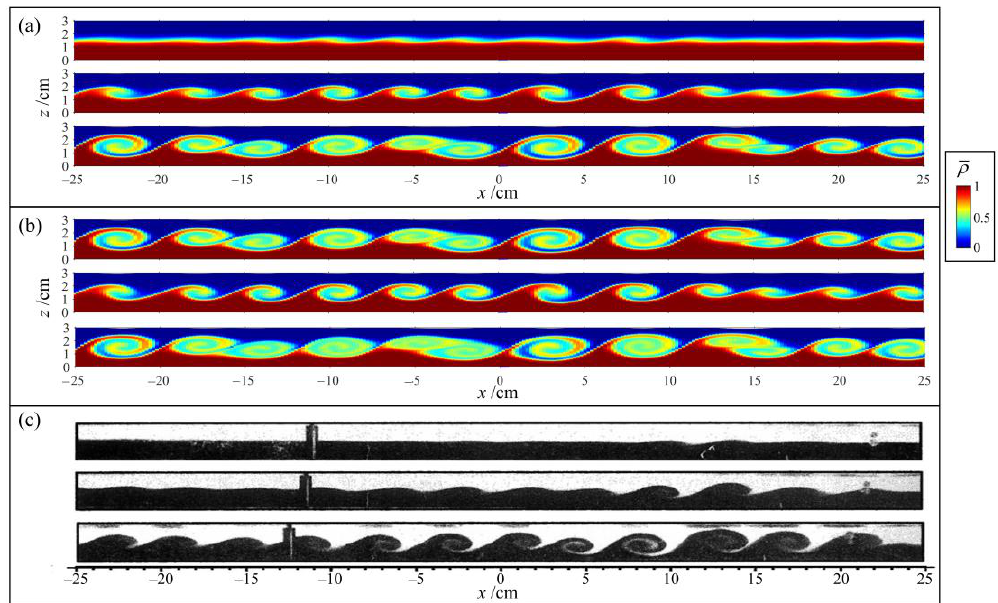
Figure 10. Three sequences of snapshots taken at half-second intervals showing the growth of instability, obtained by simulation results with ( a ) van Leer and ( b ) MC limiters in the grid resolution N x × N z = 256 × 100 and the ( c ) laboratory observations of [37]. Subfigure ( a , b ) show the results of density distribution ( 𝜌̅ = 𝜌 − 𝜌 1 𝜌 2 − 𝜌 1 ⁄ ).